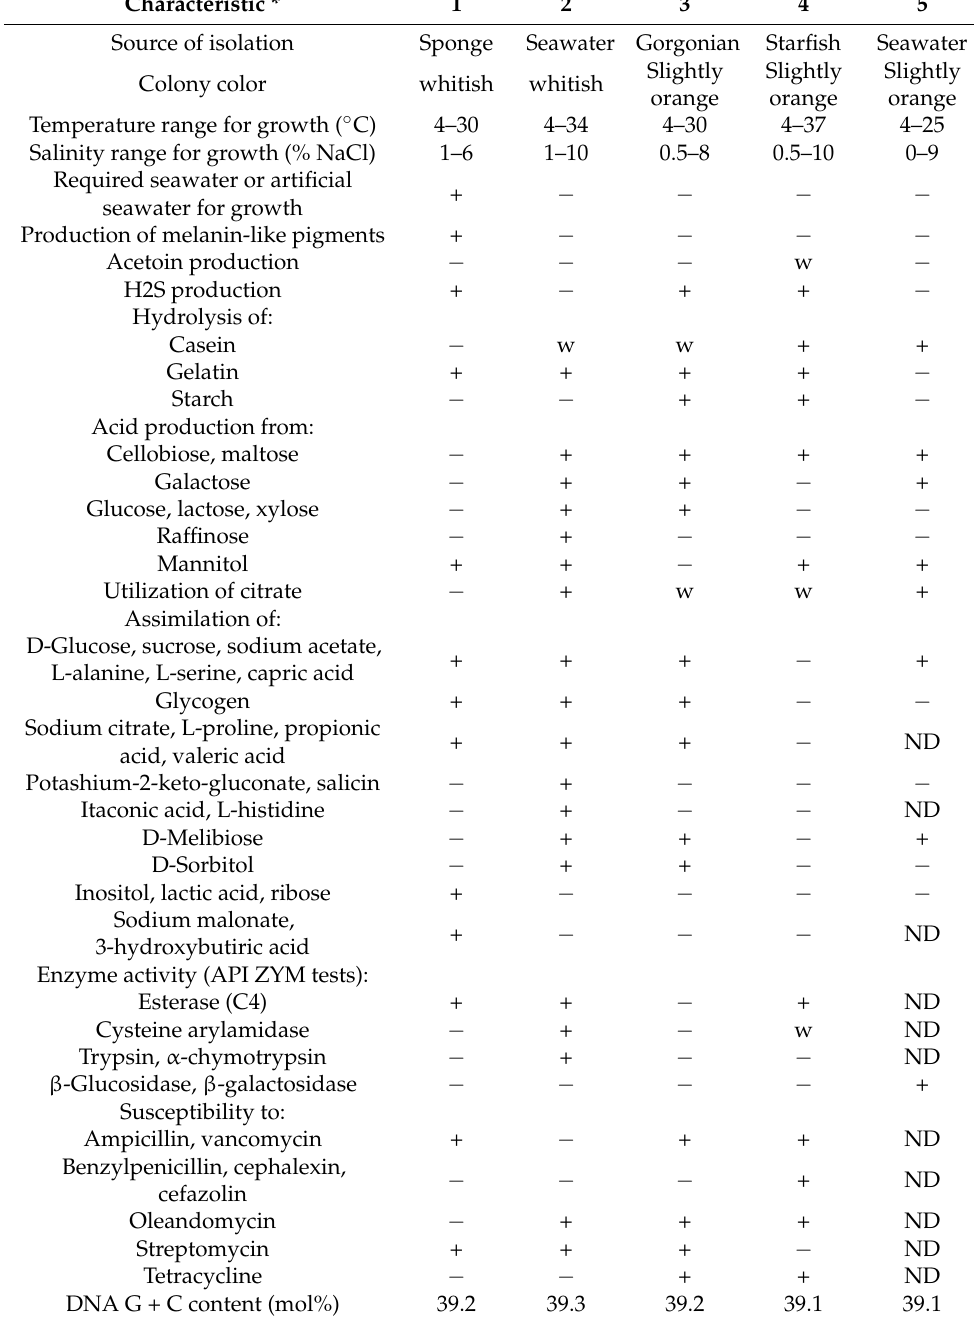
Slightly Slightly Slightly orange orange orange